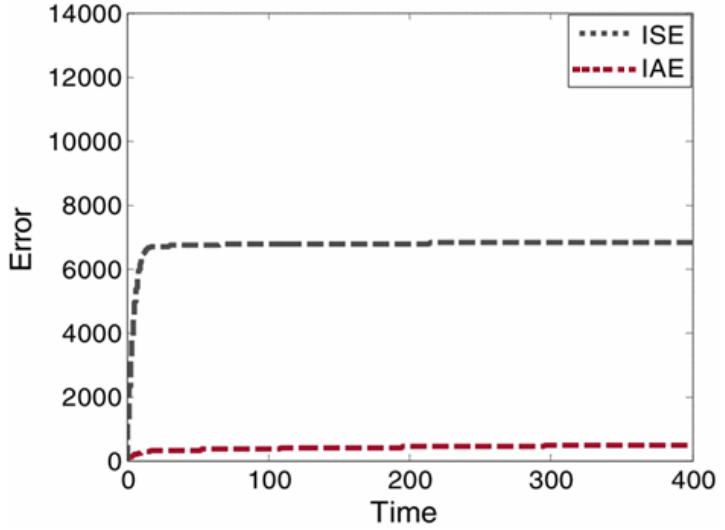
Figure 16. Ambulance error response comparison with fractional-order PID, along with GA.